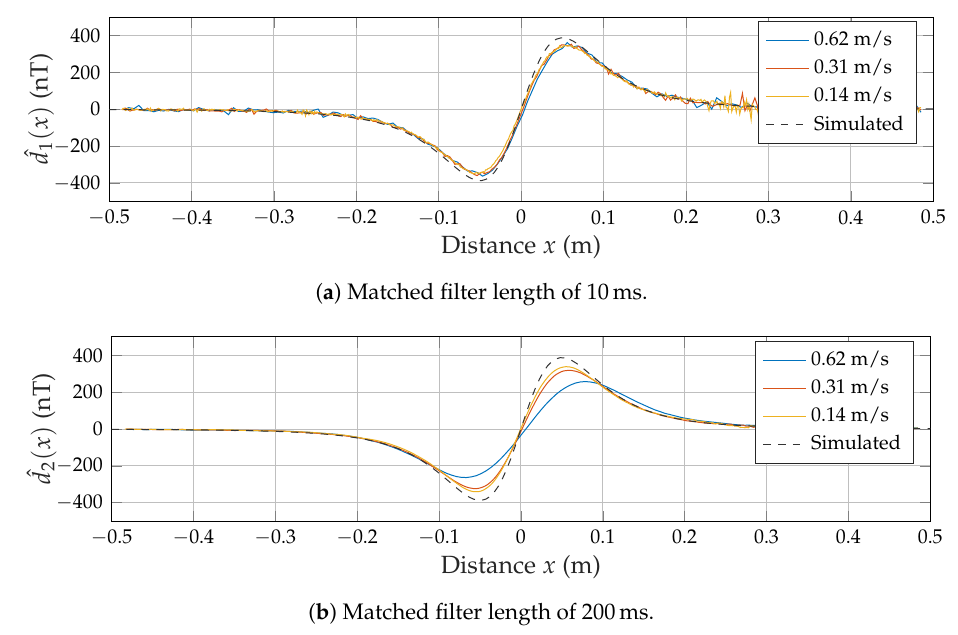
Figure 8. Measured signals for varying speeds and matched filter